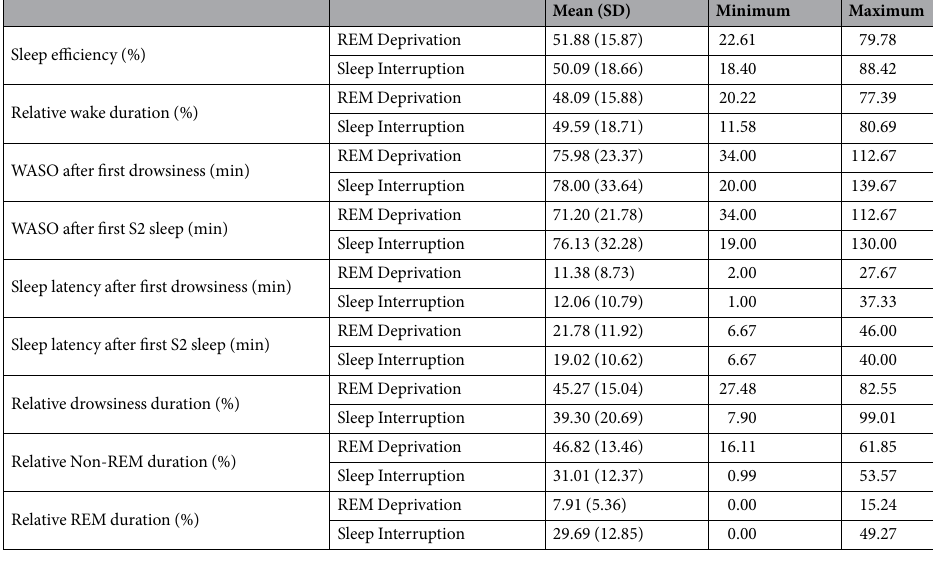
Table 1. Descriptive statistics on sleep macrostructure differences between REM Deprivation and Sleep Interruption